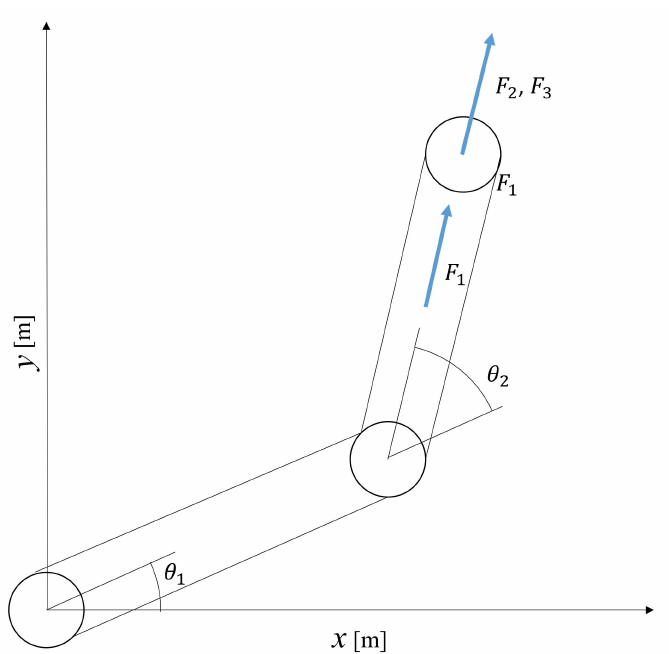
Figure 2. Forces exerted on the right